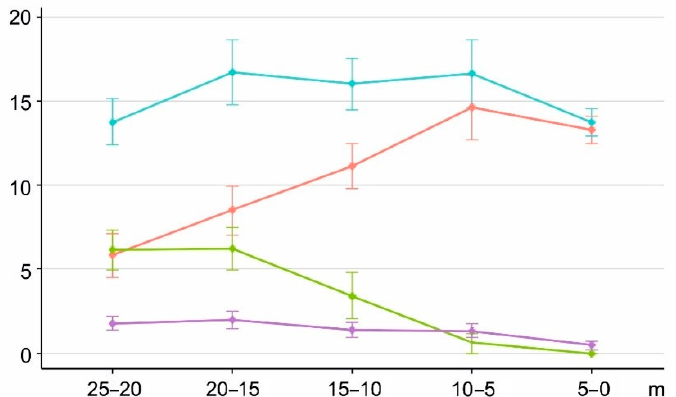
Figure 8. Changes in the abundance of epiphytic species ( bryophytes, crustose lichens, 1111epiphytic Cladonia spp., all epiphytes) with distance to spruce forest edge (means and standard errors). The abscissa indicates the distance from the interface between communities into the spruce forest; the ordinate represents the linear dimensions of epiphyte clumps.